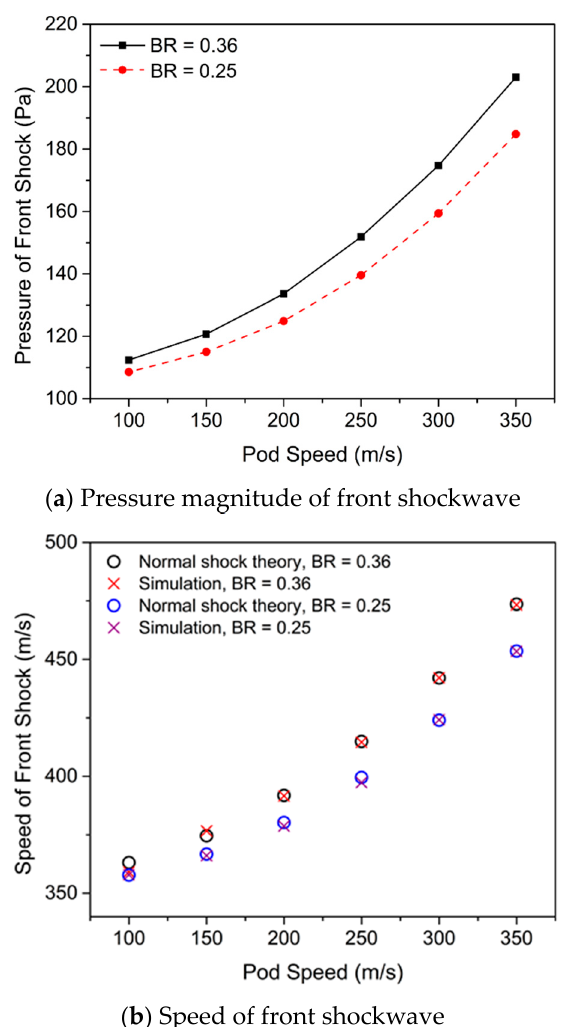
Figure 16. Pressure magnitude and speed of front shockwave. The compression wave is well-matched with the normal shockwave theory. ( a ) Pressure magnitude of compression wave traveling in the forward direction of the pod. ( b ) Comparison of compression wave propagation speeds calculated using the simulation and normal shockwave equations.